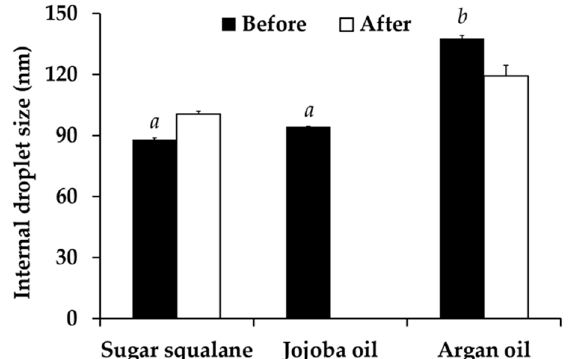
Figure 9. Internal droplet size of nanoemulsion generated using various types of oil, including sugar squalane, jojoba oil, and argan oil, before and after 8 cycles of heating-cooling condition. There letters a and b denoted significant difference between formulations analyzed using post-hock Tukey ANOVA ( p < 0.05).